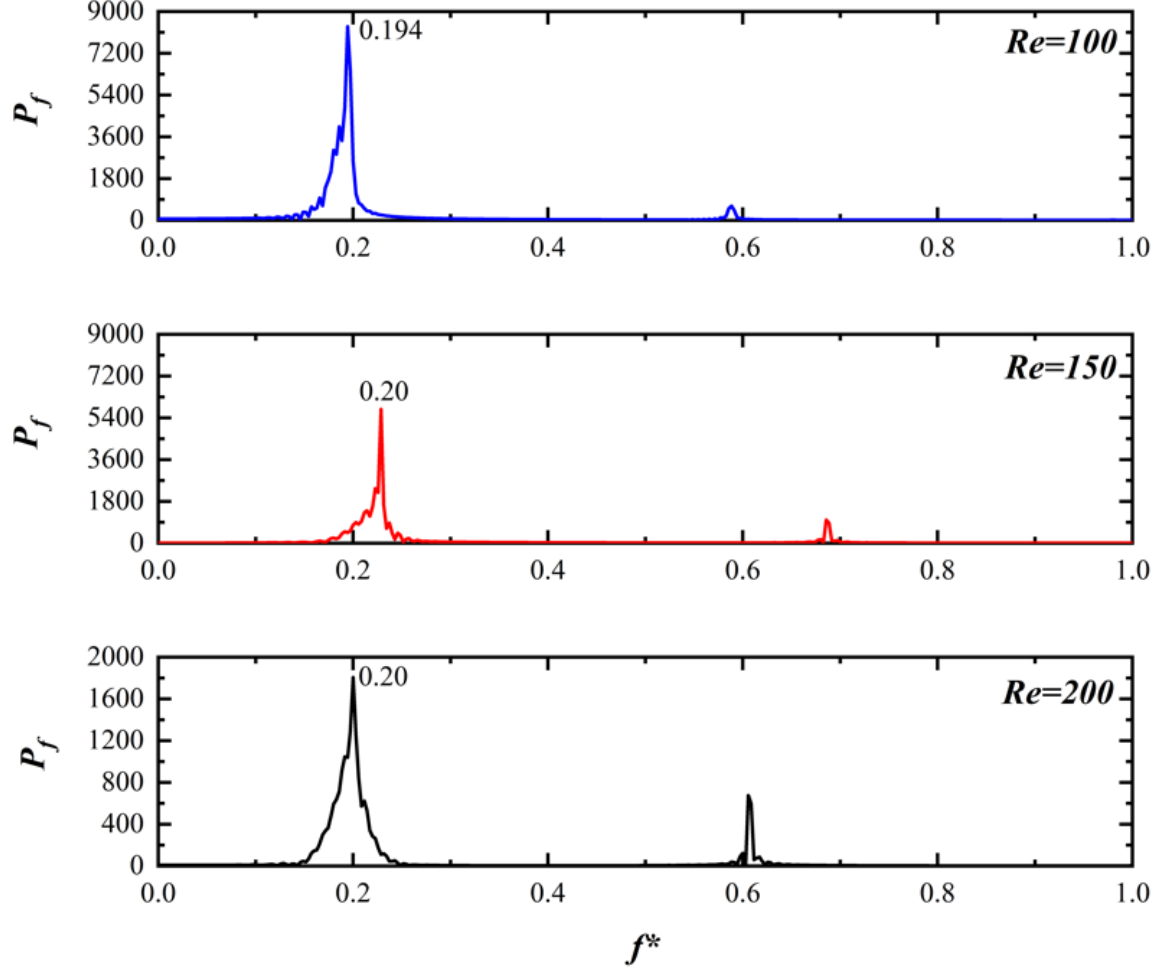
Figure 2. Frequency response of a circular cylinder at different Re = 100, 150, 200.On the x-axis, the frequency response is denoted, the y-axis shows the power spectrum density (PSD), and the z-axis shows different Re values.